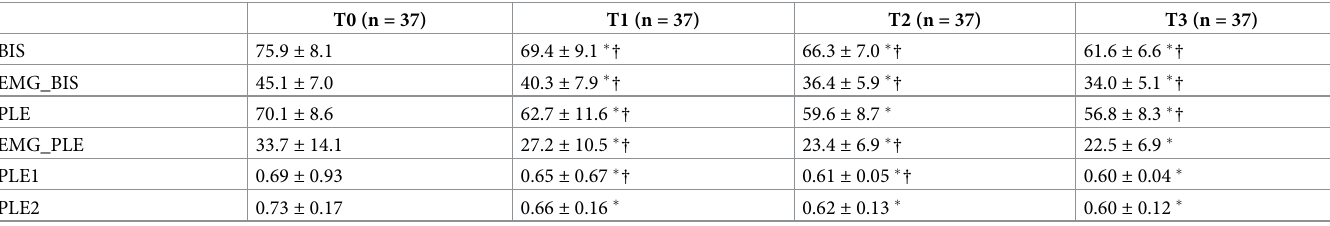
performed spectral analyses of saved EEGs in PLEM ™ data to determine whether the gradual decreases in the BIS and PLE for 3 min while maintaining a constant Ce of propofol were related to changes in EEG waves reflecting the depth of sedation/anesthesia. The group- median spectrogram showed that the power of the alpha and beta waves became stronger and weaker, respectively, over time (Fig 3). The changes of BIS and PLE for 4 minutes after administration of rocuronium. No sig- nificant differences were observed in propofol Ce at LOC, which was constantly maintained in all patients during the study period between group C (3.4 ± 0.8 μ g/ml) and R (3.6 ± 0.6 μ g/ml) (P > 0.05) (Fig 2A). The BIS immediately before administering rocuronium or saline (at TR0) to group C or R was 59.3 ± 9.9 or 60.0 ± 5.6, respectively, however, no significant differences were observed between the two groups (P > 0.05) (Table 4). At 2, 3, and 4 min after injecting saline in group C and 1, 2, 3, and 4 min (at TR1, TR2, TR3, and TR4) after injecting rocuro- nium in group R, the BIS decreased significantly compared to TR0 (P < 0.05), but no signifi- cant differences were observed between the two groups at any of the time points (P > 0.05). The EMG_BIS at TR1, TR2, TR3, and TR4 decreased significantly compared to TR0 only in group R (P < 0.05). The EMG_BIS in group R was significantly lower than that in group C at TR2 and TR3 (P < 0.05) (Table 4). PLE values at TR0 in group C and group R were 53.4 ± 8.4 Table 3. Changes in BIS and PLE for 3 min while propofol Ce at LOC Was maintained before neuromuscular